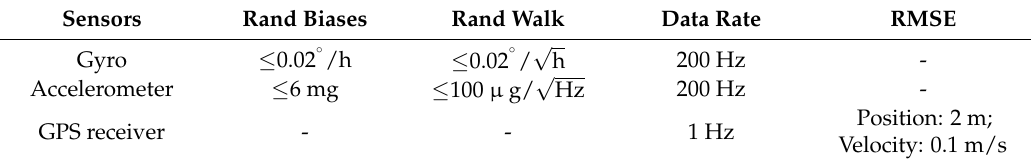
Table 6. Performance of the inertial measurement unit (IMU) and the GPS receiver.